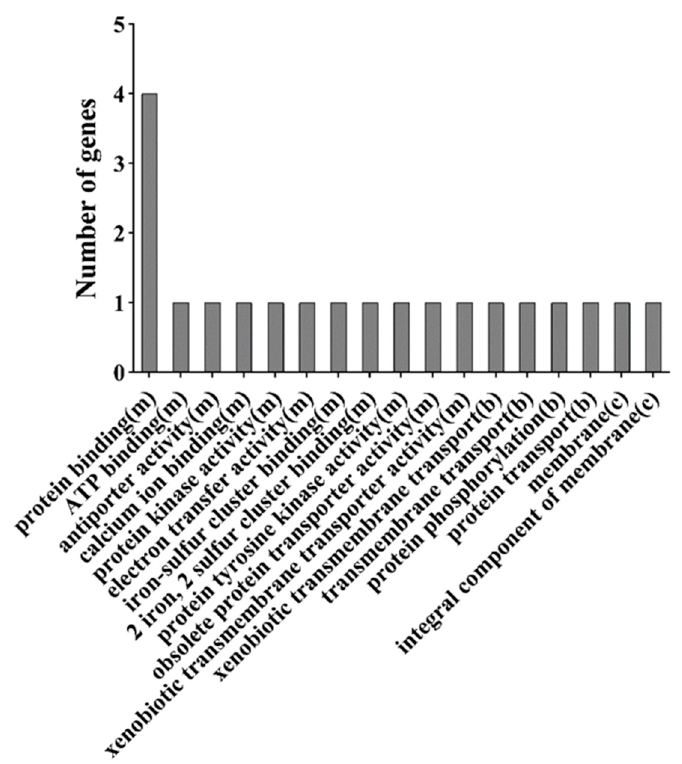
Figure 4. GO term analysis of genes within 50 kb upstream and downstream of TGS377. (m): Molecular function; (b): biological process; (c): cellular